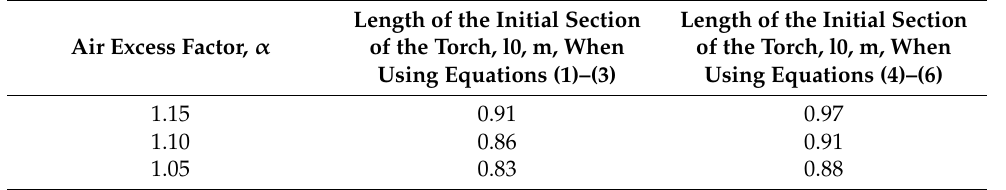
Table 2. Results of research on Equations